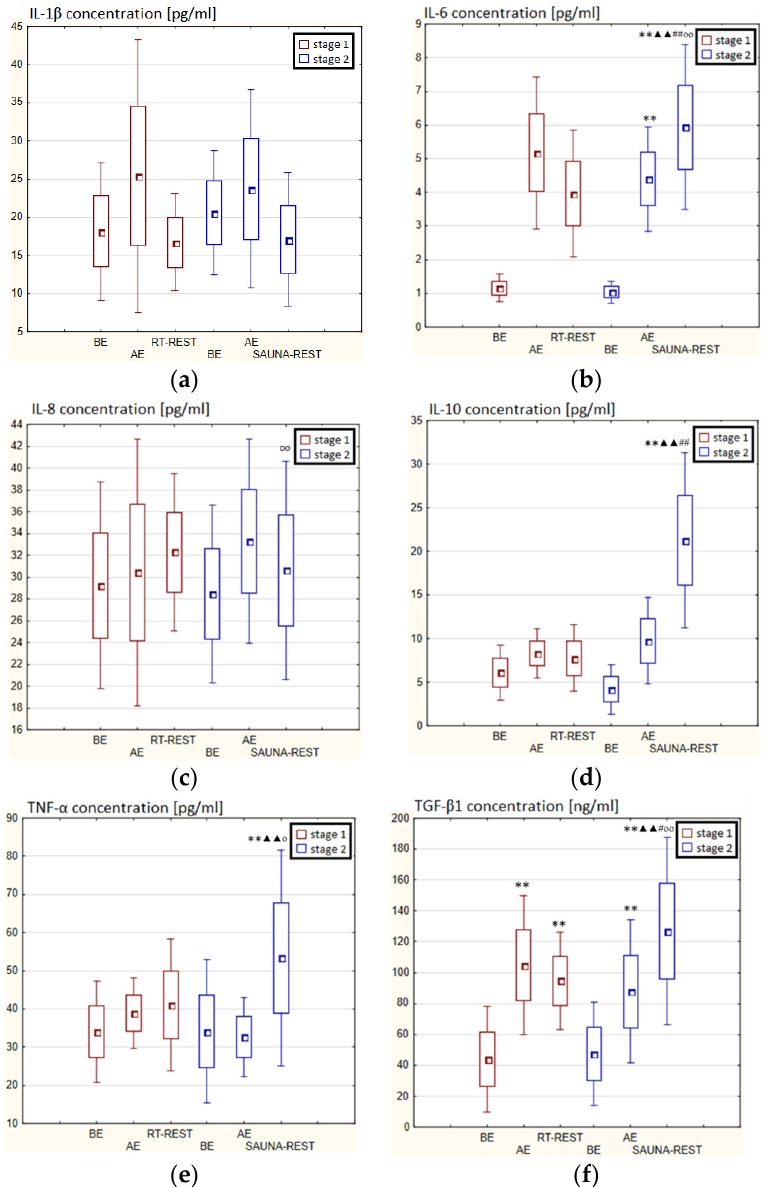
Figure 9. The concentration of selected cytokines in blood serum of novices ( n = 23) in Experiment II: ( a ) IL-1 β concentration; ( b ) IL-6 concentration; ( c ) IL-8 concentration; ( d ) IL-10 concentration; ( e ) TNF- α concentration; ( f ) TGF- β 1 concentration. Data are presented as the mean values ± SD. IL-1 β — interleukin 1 β , IL-6—interleukin 6, IL-8 - interleukin 8, IL-10—interleukin 10, TNF- α —tumor necro- sis factor α , TGF- β 1—transforming growth factor β 1, BE—before exercise, AF—after exercise, RT-